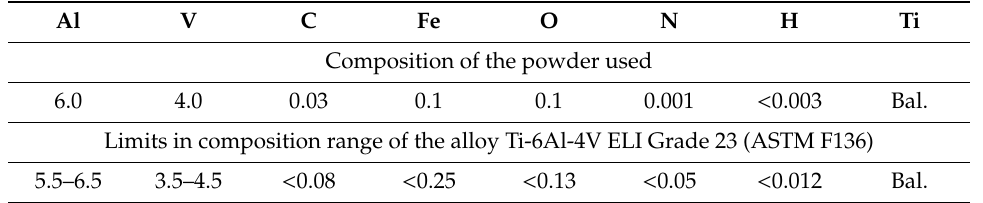
Table 2. Powder composition and limits in composition range of the alloy Ti-6Al-4V ELI Grade 23 (weight %).